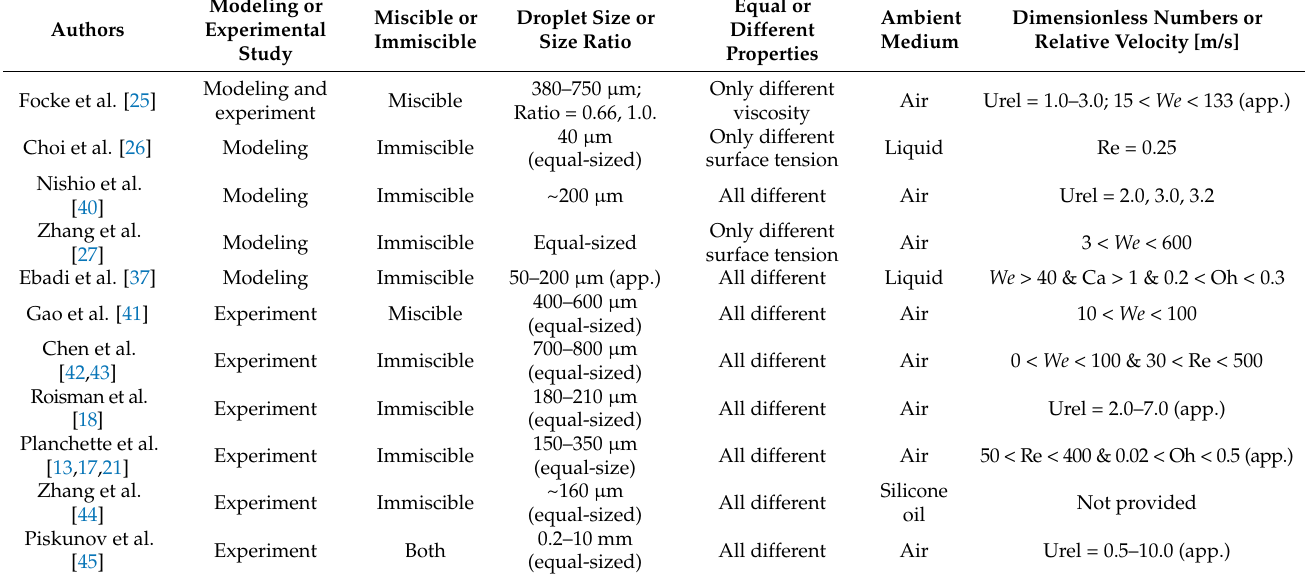
Table 1. Summary of the studies of the collisions between two droplets of different